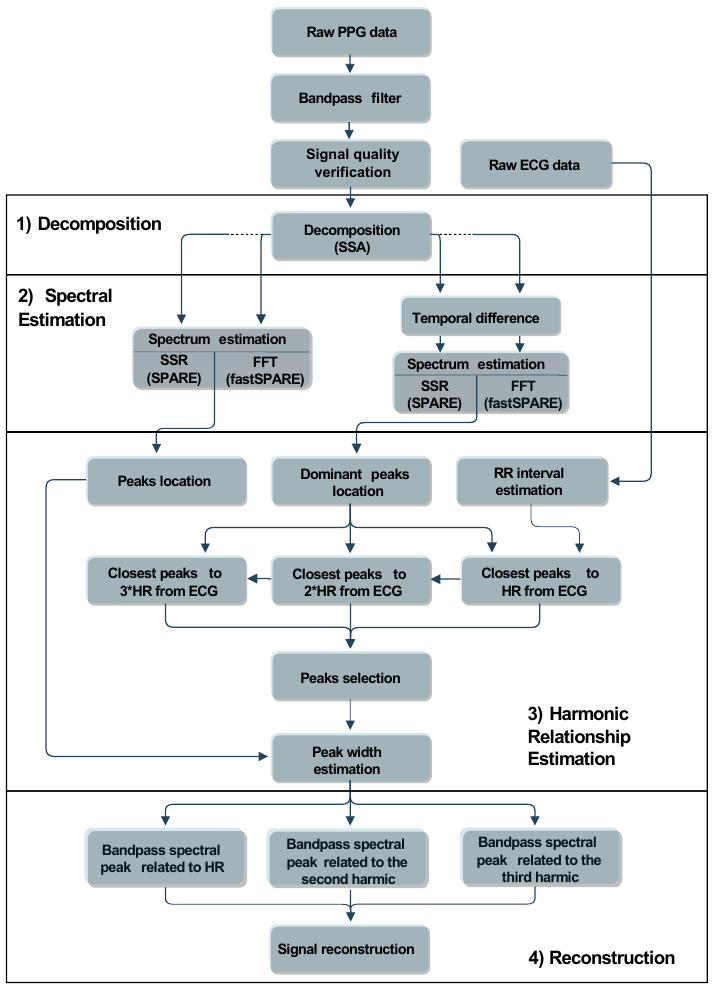
Figure 3. Block diagram of the SPARE algorithm. SSA: singular spectrum analysis, SSR: sparse signal reconstruction, FFT: fast Fourier transform, HR: heart rate, RR interval: beat-to-beat time interval detected from the electrocardiogram